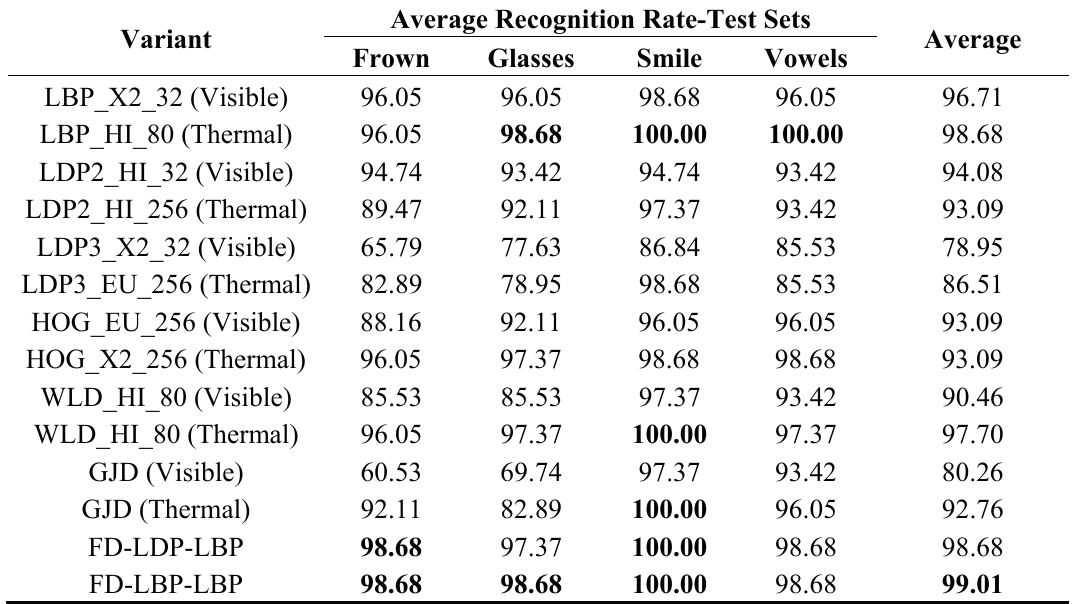
Table 4. Average recognition rate for the PUCV-VTF database. Different test sets against the entire gallery sets. In bold are the best results per test